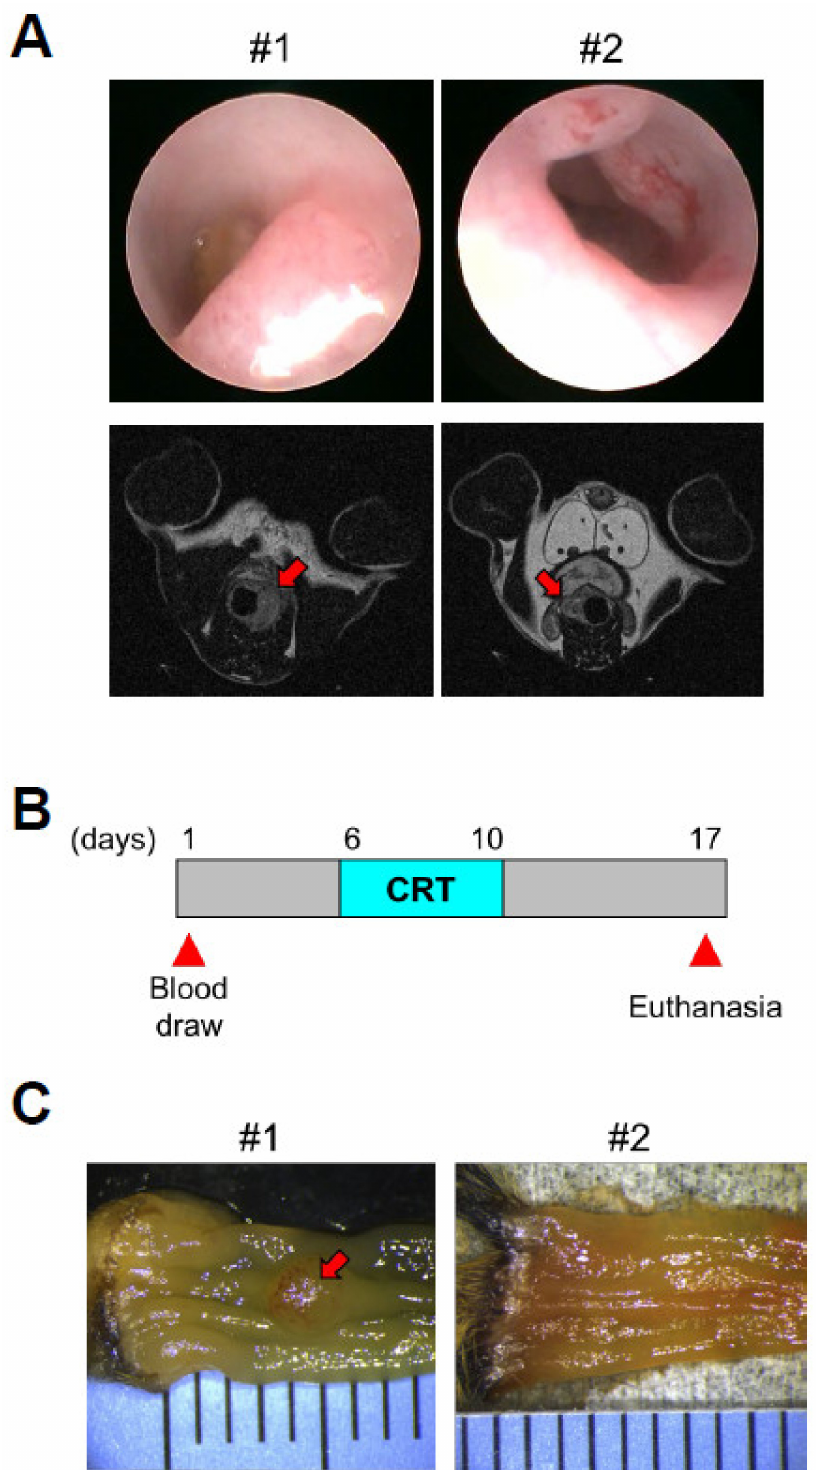
Figure 1. Chemoradiation treatment of iKAP mice with rectal tumors. ( A ). Endoscopic images (top) and MRI scans (bottom) of rectal tumors. Red arrows in MRI scans indicate rectal tumors. ( B ). Outline of the experimental design for intraperitoneal injection of 5-FU and concurrent radiation. ( C ). Macro- scopic images of colons of iKAP mice with residual tumor (Non-regression) (#1) and with complete tumor regression (Regression) (#2). A red arrow indicates residual tumors. CRT: